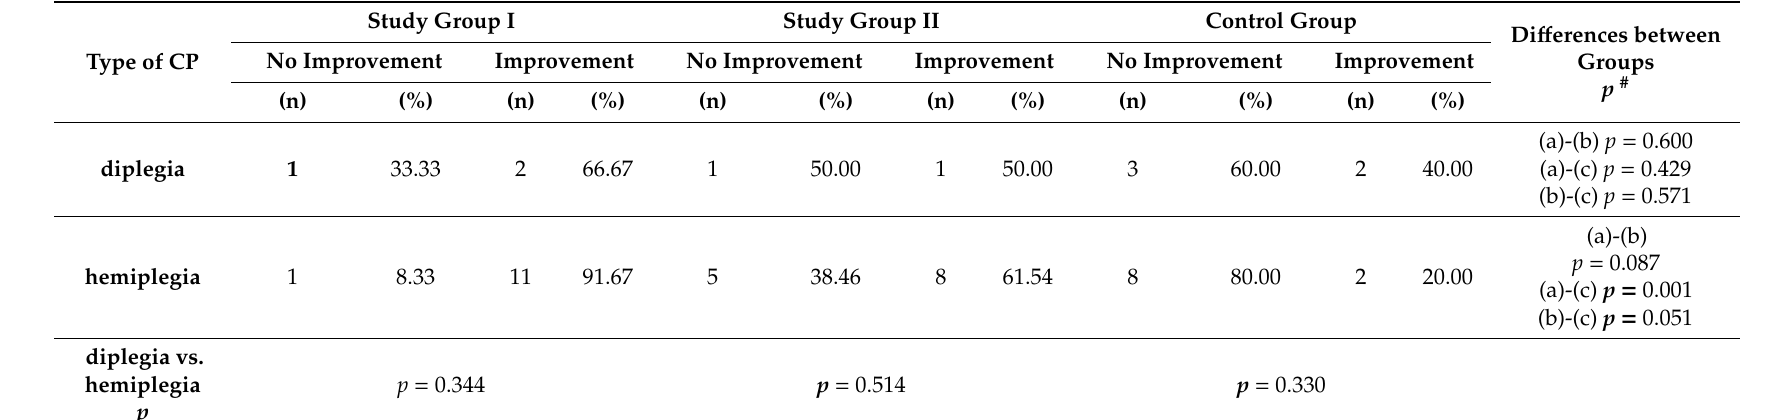
Table 3. Changes in the SAS scale rating for the type of CP.